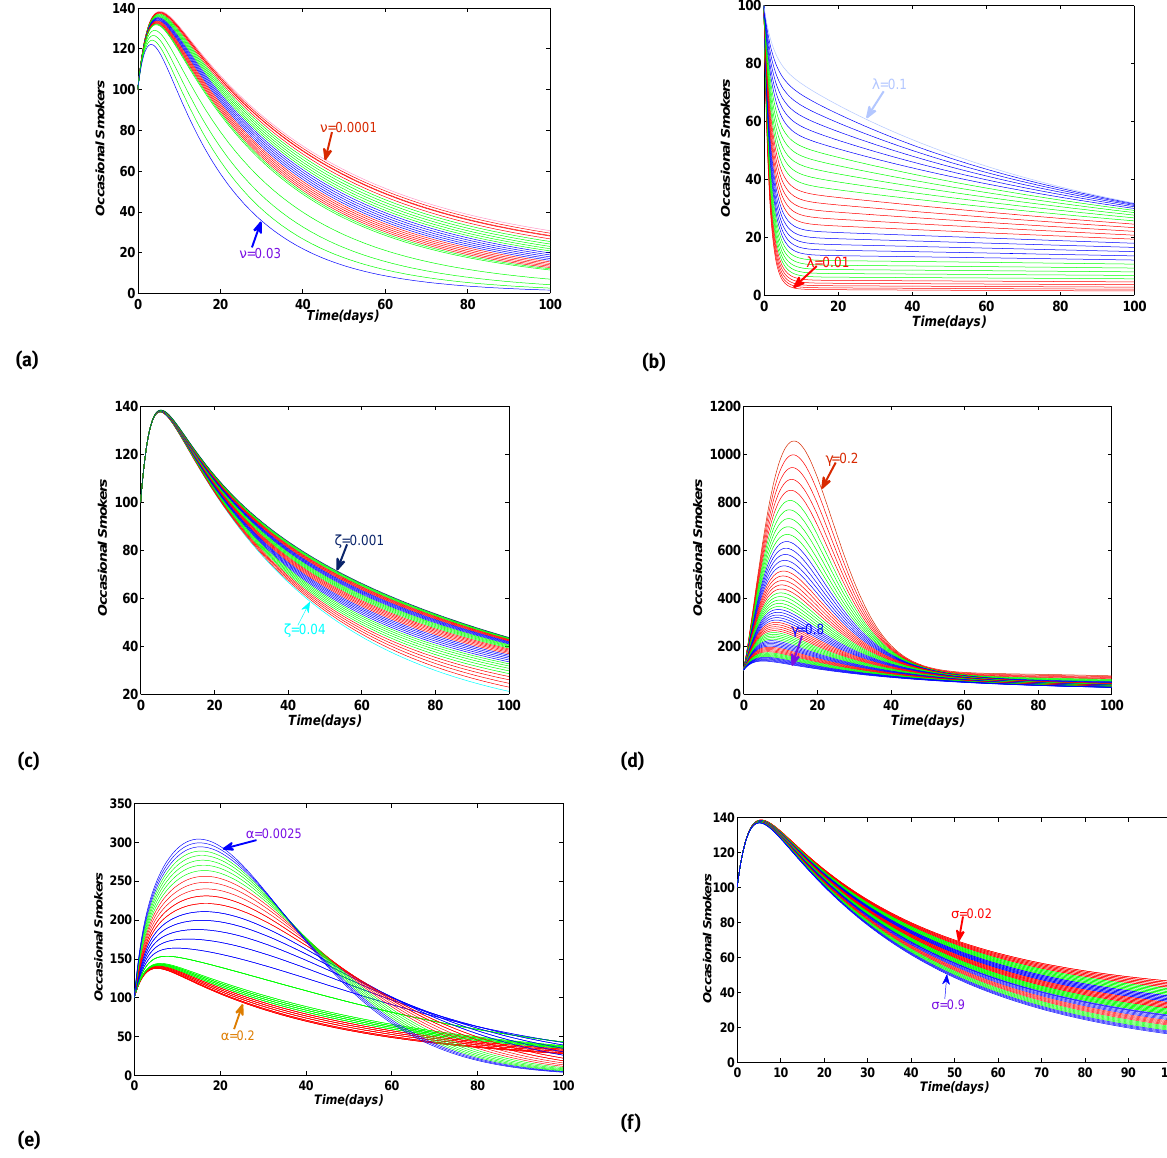
Figure 3: Variation in the endemic level of O * with respect to model parameters